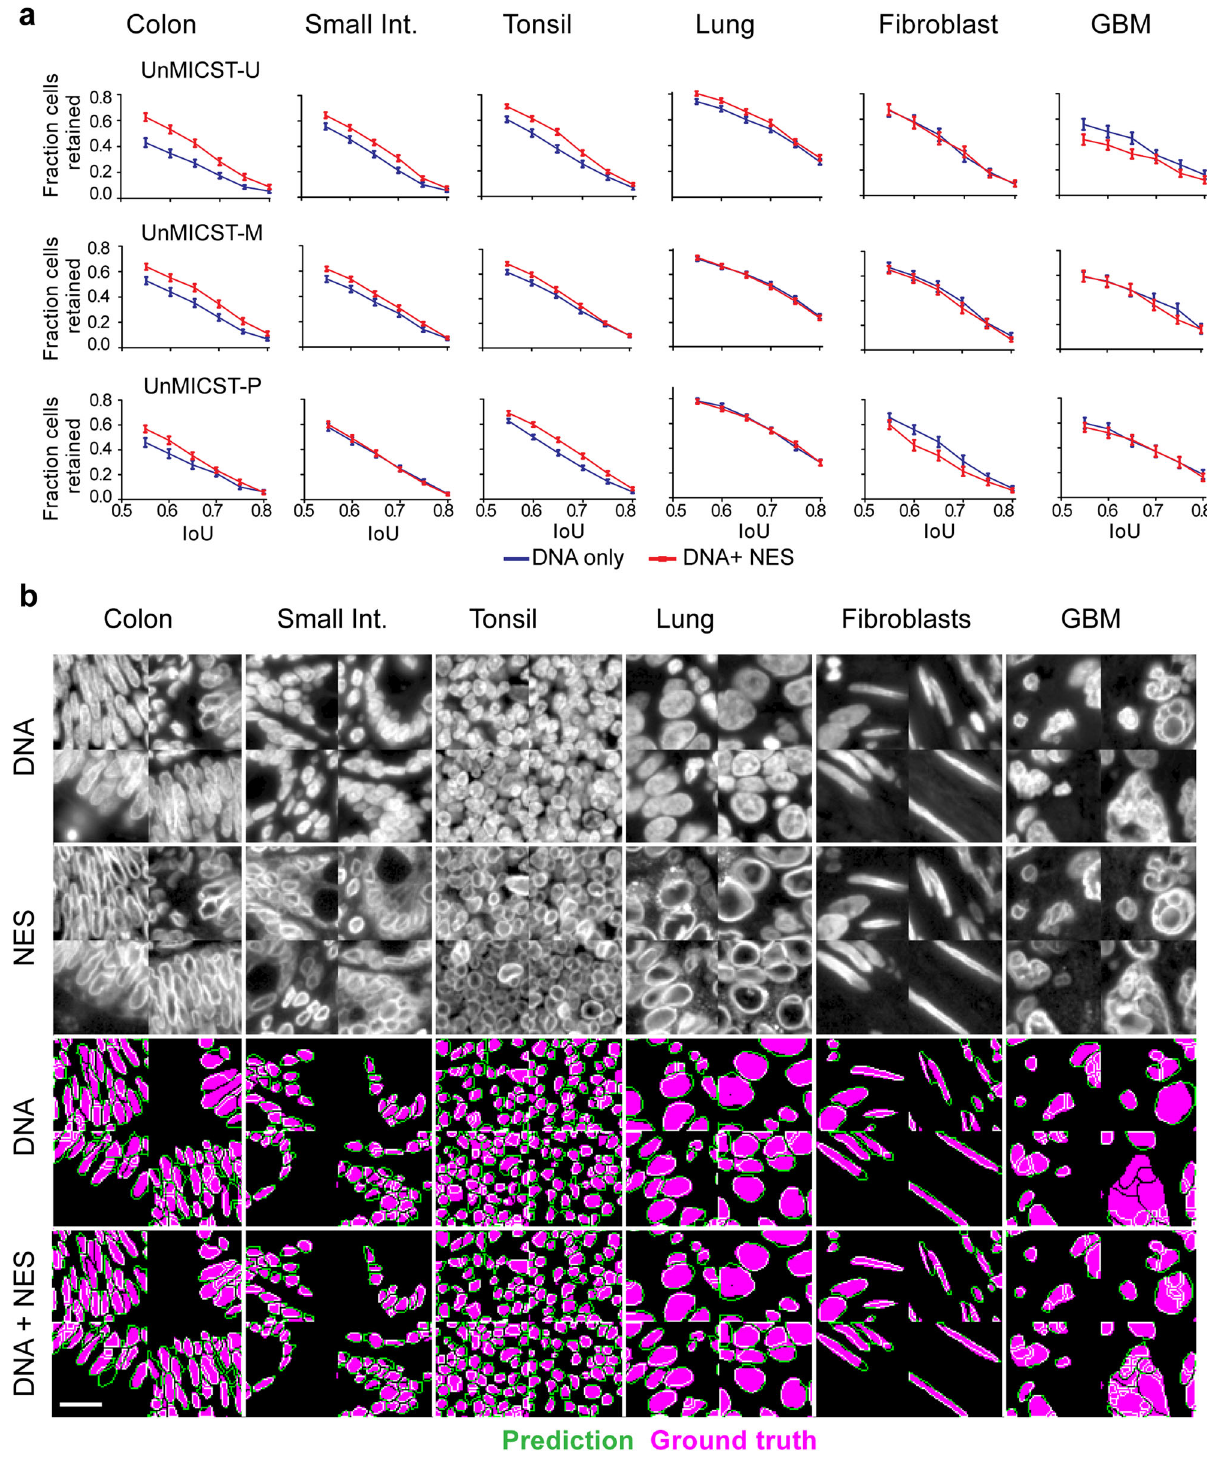
Fig. 3 NES with DNA improves nuclear segmentation. NES – nuclear envelope staining. Assessing the addition of NES as a 2nd marker to DNA on segmentation accuracy on a per tissue and per model basis. a Variable IoU plots comparing the DNA-only model (blue curve) and the DNA + NES model (red curve) across frameworks. Adding NES increased accuracy for densely packed nuclei such as colon, small intestine, tonsil, and to some extent, lung tissue. Error bars are standard errors of mean. b Representative grayscale images of tissues stained with DNA and NES comparing their variable morphologies, followed by UnMICST-U mask predictions (green) overlaid onto ground truth annotations (purple). In tissue with sparse nuclei, such as fi broblasts from prostate tissue, NES did not add an additional bene fi t to DNA alone. In tissues where NES does not exhibit the characteristic nuclear ring, as in glioblastoma, the accuracy was similarly not improved. Scale bar denotes 20 μ